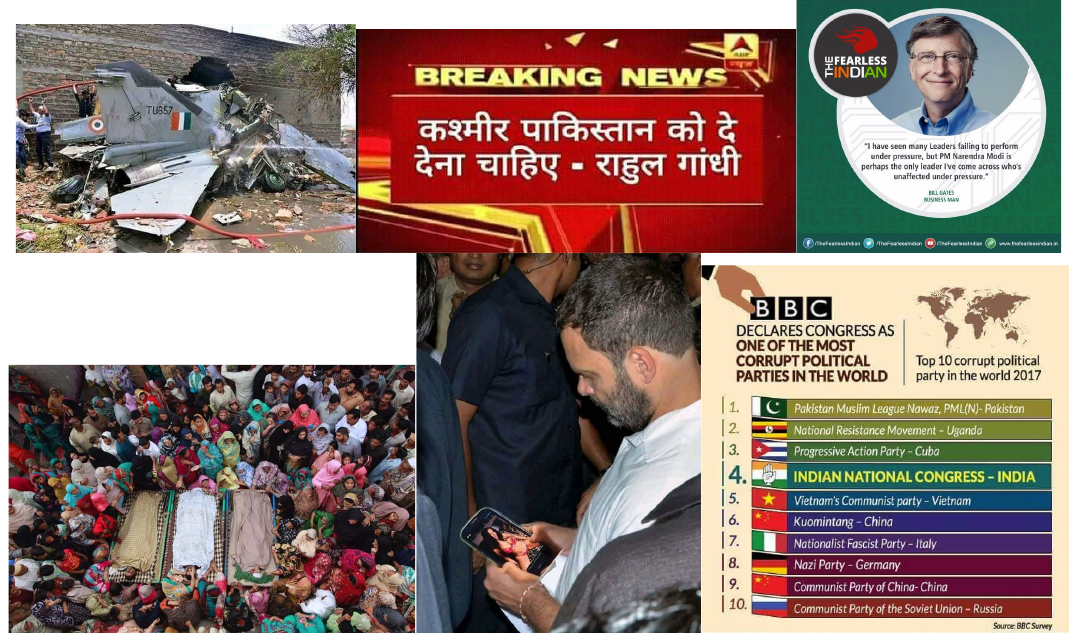
Figure 1. Types of misinformation. (left, top/bottom) Images taken out of context — both these are old images claimed to be a result of India's attack on Pakistan; (center) Photoshopped images of (top) doctored screenshot of a TV news program and (bottom) a politician browsing porn; (right) Fake quote by Bill Gates, and a fake poll by BBC. Finding 3: Automatically identifying misinformation images is non-trivial and